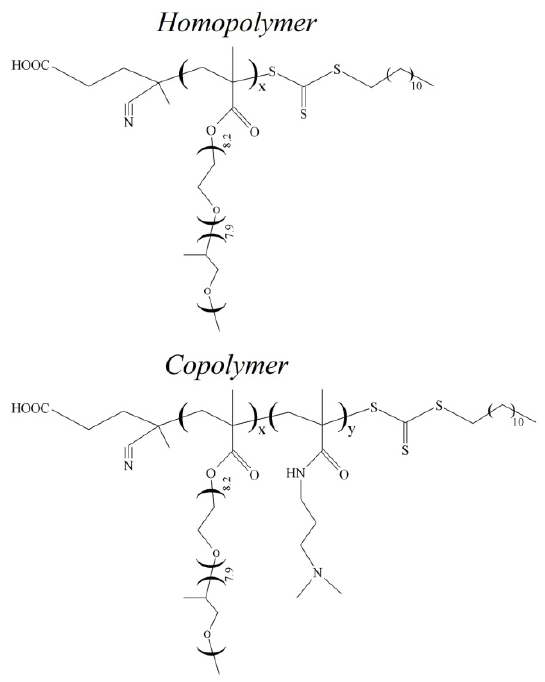
Figure 1. Structures polyOPG 8 OEG 8 MA and polyOPG 8 OEG 8